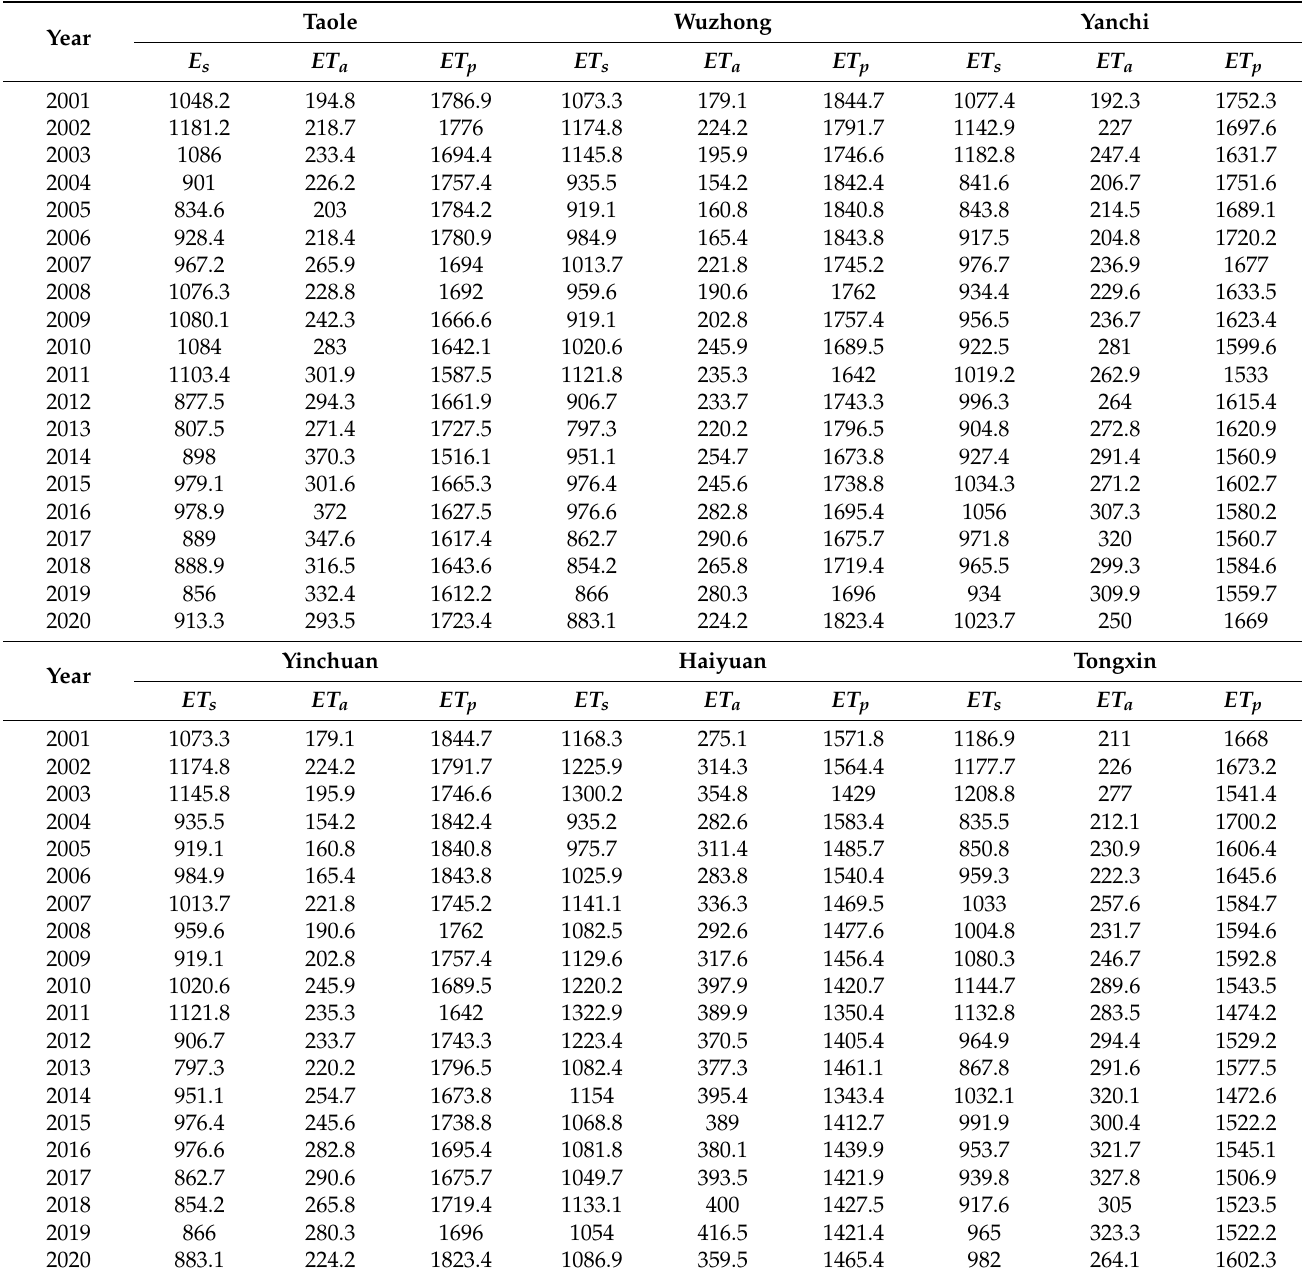
Table 6. Observations of BPI pan ( ET s ), MODIS AET ( ET a ) and MODIS PET ( ET p ) over the past 20 years at six meteorological stations in Ningxia